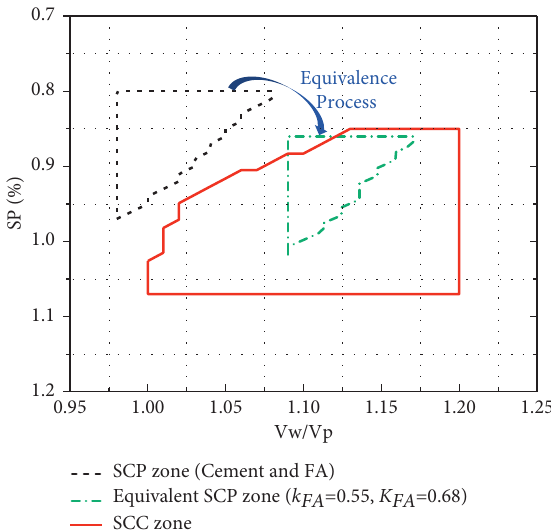
Figure 8: Comparison of different zones with cement and FA as powder.